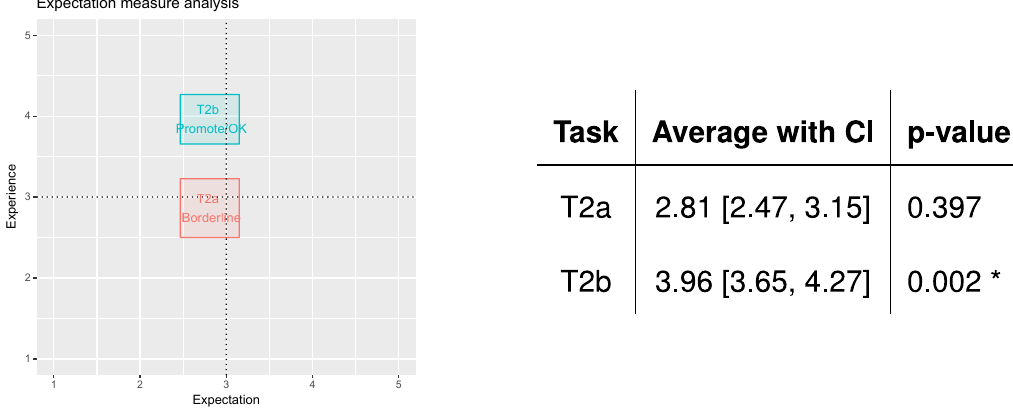
Figure 10: EM analysis for the acufenometry task, where the new version (T2b) overcomes the old version (T2a).